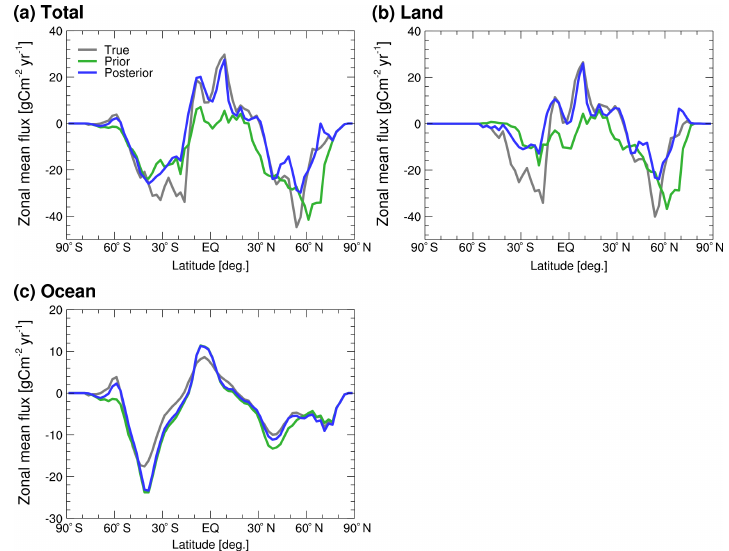
Figure 10. Latitudinal profiles of annual zonal mean CO 2 fluxes (gray: true; green: prior; blue: posterior) for the total (a) , terrestrial (b) , and ocean (c) areas. Note that fossil fuel emission is not